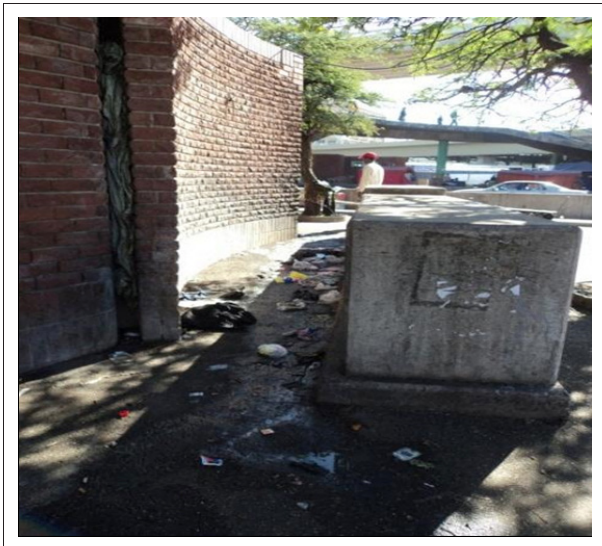
FIGURE 8: Area used as ablution facility when public ablution facilities are closed after 16:00